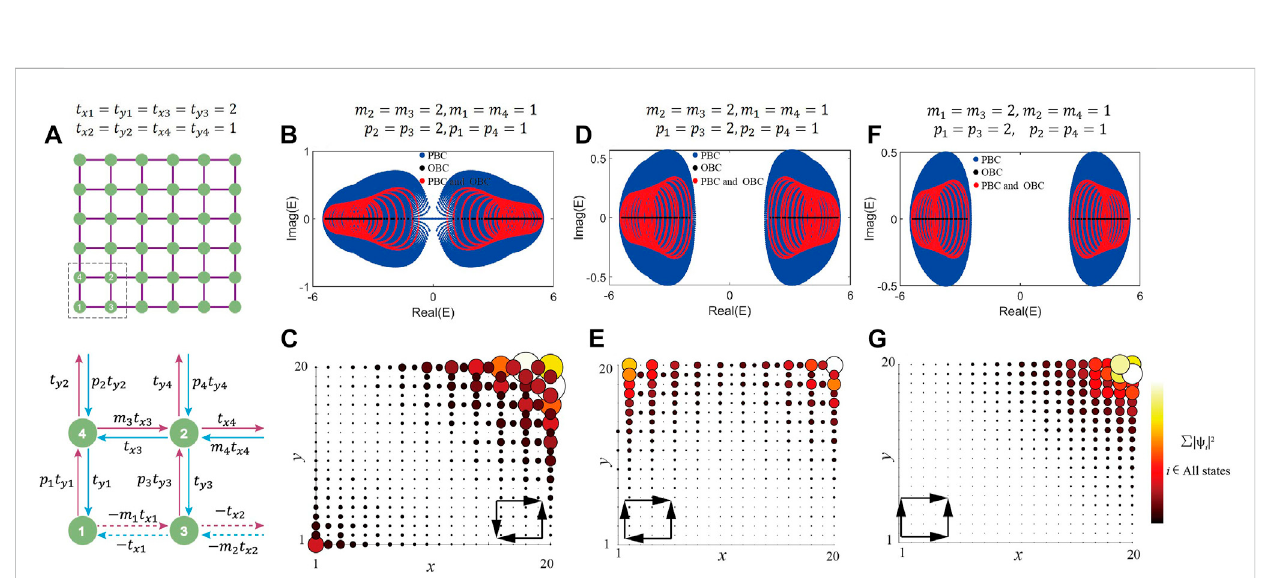
FIGURE 4 (A) Diagram of a 2DSSH-likelatticemodel with its primitive unit inthe inset below the mainpanel. (B) – (C) Complex energy spectra under three different boundary conditions and HD-NHSE with skin modes at two diagonal corners. (D) – (E) Complex energy spectra and HD-NHSE with skin modes at two parallel corners. (F) – (G) Complex energy spectra and HD-NHSE with skin modes at an isolated corner. The insets inside panels (C) , (E) and (G) schematically show the net non-reciprocal pumping